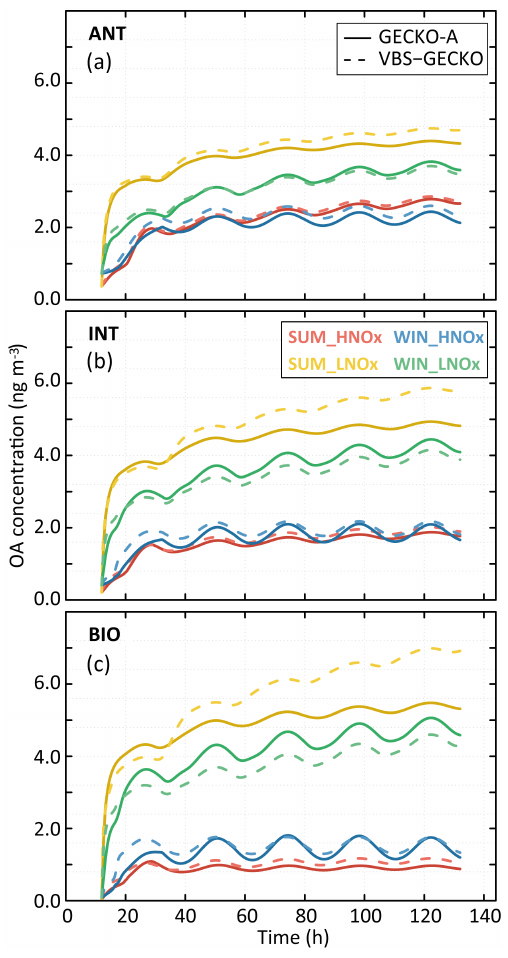
Figure 8. Simulated organic aerosol (OA) mass with GECKO-A (continuous lines) and VBS-GECKO (dashed lines), for the differ- ent evaluation scenarios using C oa = 2µgm − 3 . Panel (a) presents results for the ANT cases, (b) for the INT cases and (c) for the BIO cases. The different colours represent the different scenarios (see text).